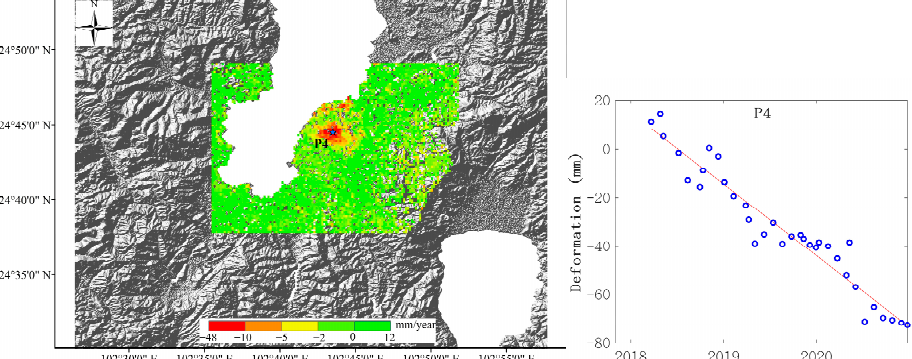
Figure 8. Deformation rate in the east of Dianchi Lake and time series cumulative settlement diagram of P4.